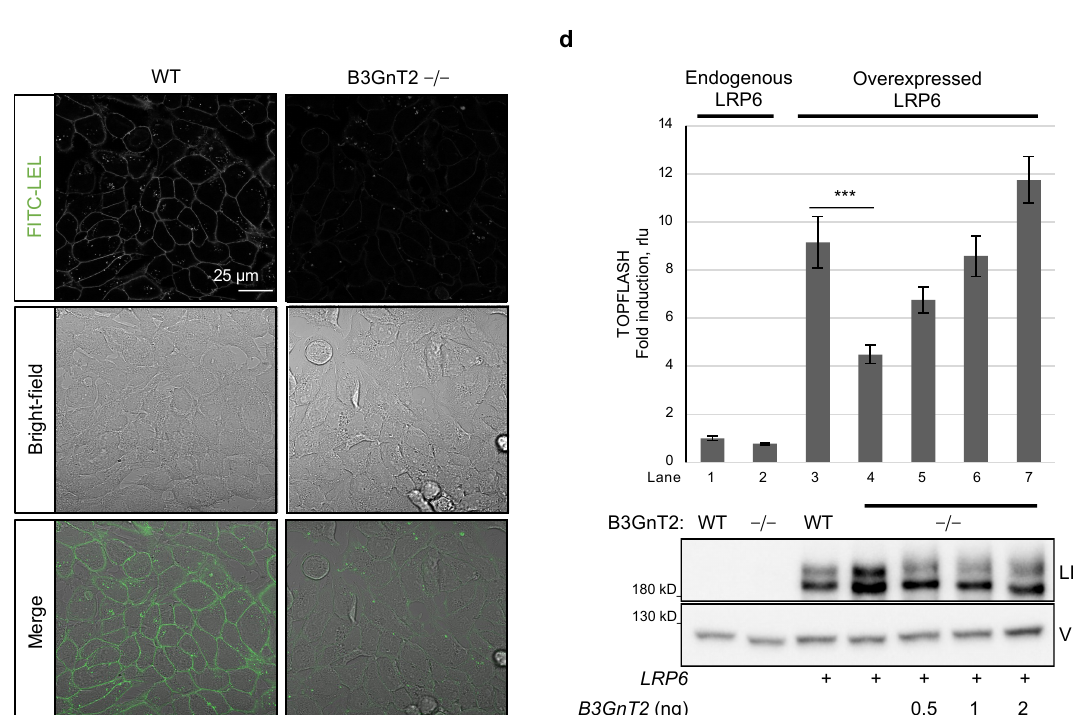
Figure 5. Human B3GnT2 promotes cell surface LRP6 and is required for Wnt/ β -catenin sig- nalling. ( a ) Schematic overview of cell surface LRP6 assay is shown on left. ( b ) Cell surface lumi- nescence/fluorescence assay for HiBiT-LRP6-mCherry. HEK293T cells in 96-well plates were transfected as indicated with HiBit-hLRP6-mCherry (20 ng), mMesd (5 ng) and hB3Gnt2 (0.5 ng). Cells were washed after 48 h with HBSS and treated with detection reagent constituting LgBiT (1:200), Fumarazine (1:100), HEPES (1:100) FBS (5%) and phenol free DMEM medium. The bioluminescence from reconstituted HiBit/LgBiT (Nluc) was measured using a Caloristar multiplate reader and the ratio of bioluminescence to fluorescence was plotted as shown in the graph. Data represent mean ± SD. ** p < 0.01; *** p <